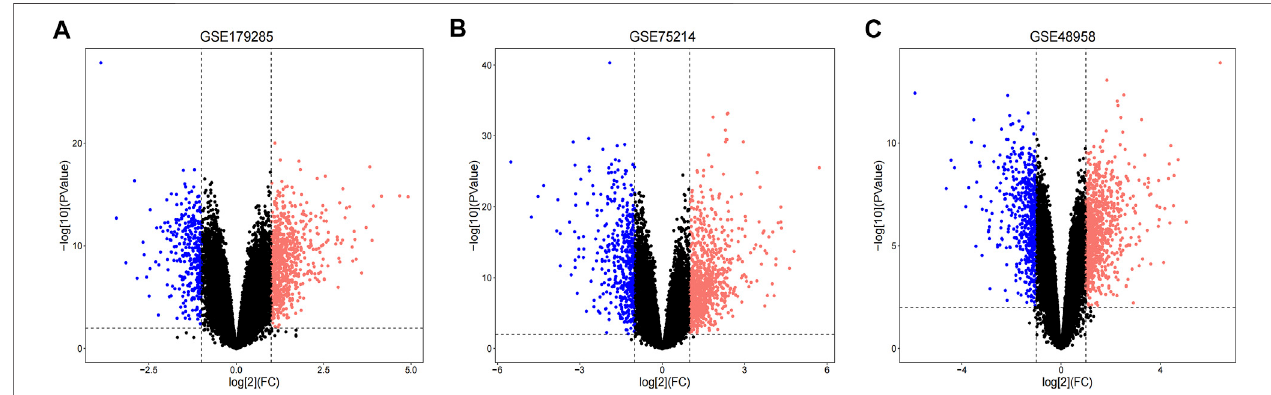
FIGURE 1 | Volcano plots indicating differentially expressed genes (DEGs) among the control and UC groups. (A – C) DEGs of the GSE179285, GSE75214 and GSE48958datasetsareshown,separately.reddatapointsrepresentup-regulatedgenesandblueonesrepresentdown-regulatedgenes.Geneswithoutanysigni fi cant differences are in